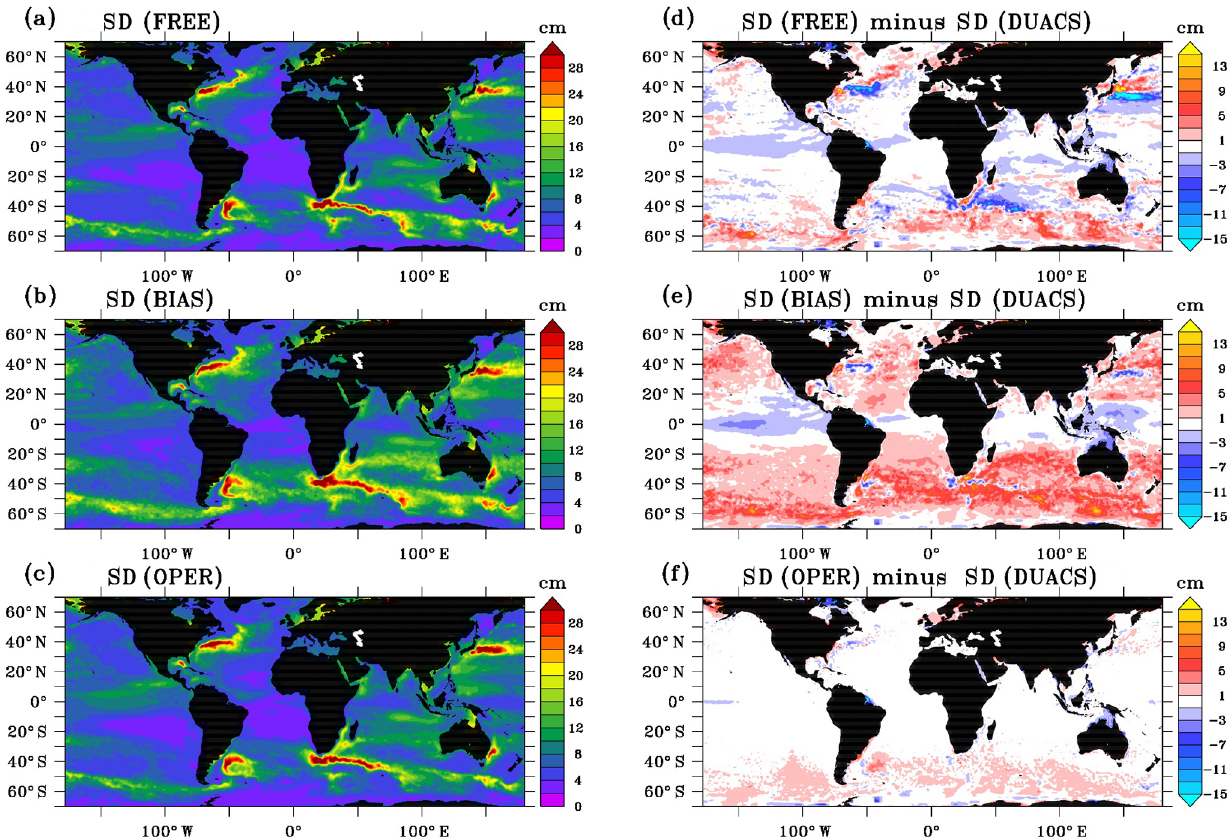
Figure 14. 2007–2015 SSH standard deviation (diagnostics made with one point every three horizontally and 1 day every 5) of the 1 / 12 ◦ PSY4 simulations (a, b, c) and difference of the SSH model standard deviation from the one of the DUACS gridded product (d, e, f) . Units are